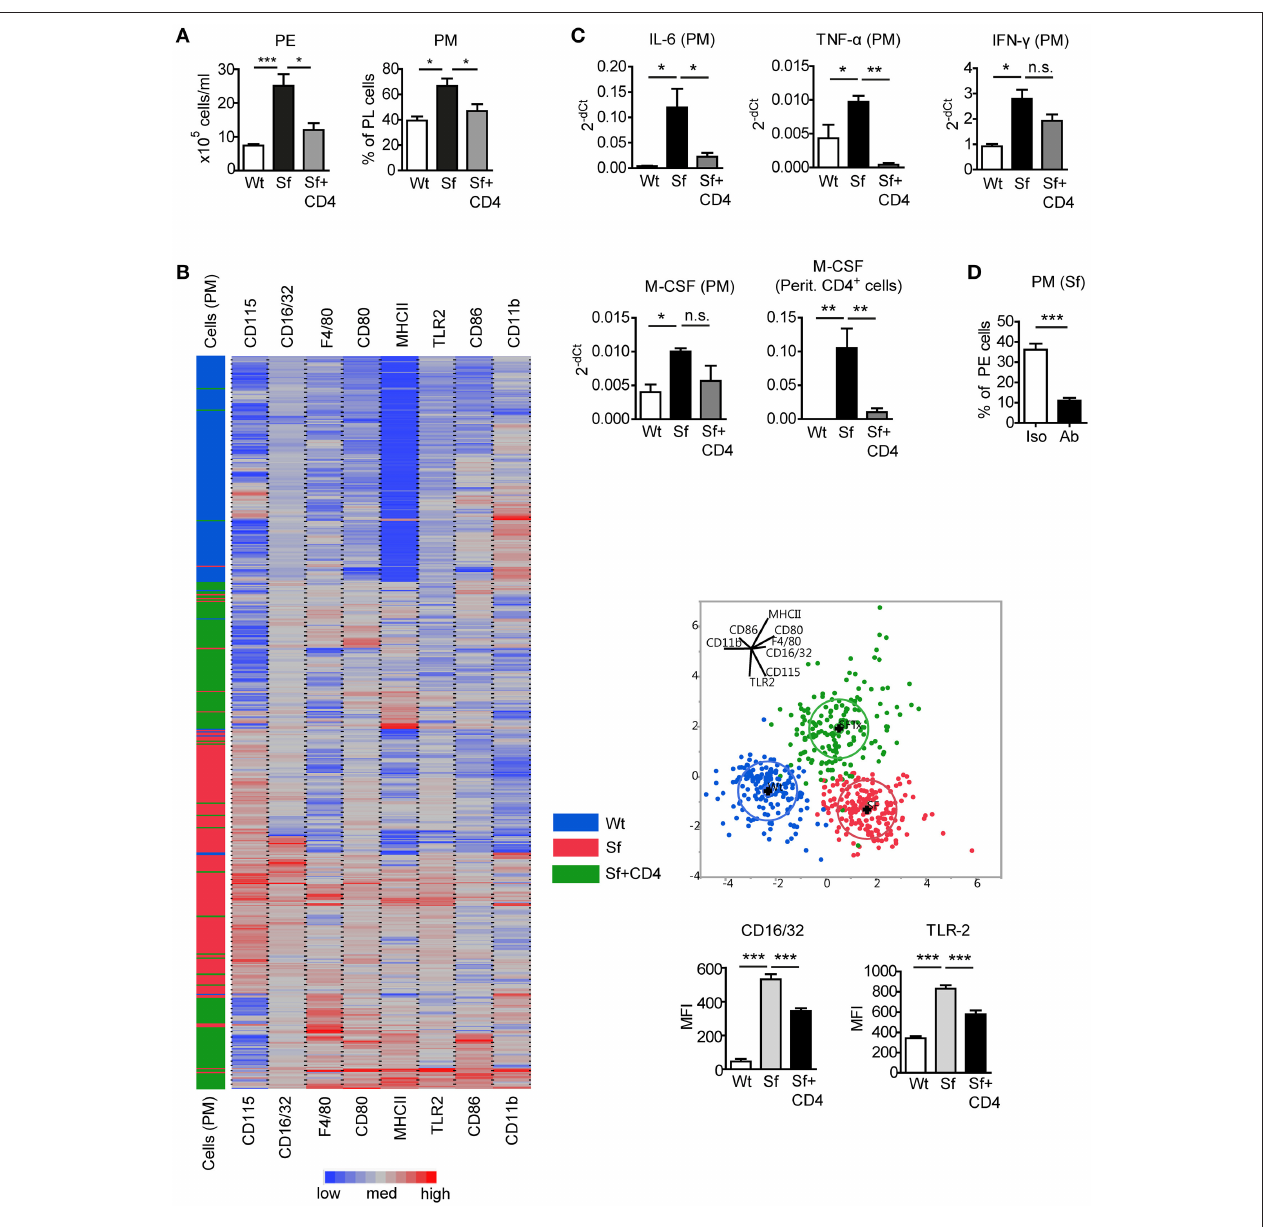
FIGURE 4 | Injection of Wt CD4 + T cells to Sf mice restores PM number and inflammatory cytokine expression. (A) Total peritoneal exudate (PE) cells and percentages of peritoneal macrophages (PM) in controls (Wt), scurfy mice (Sf), and adoptively transferred Sf mice with Wt CD4 + cells (Sf + CD4), analyzed by automated cell counter and flow cytometry, respectively ( n ≥ 5). (B) Heatmap, linear discriminant analysis, and bar graphs of cell surface markers measured by chipcytometry on gated CD115 + CD11b + F4/80 + PM ( n = 200 cells per group, pooled from more than 3 mice). (C) Impact of adoptive Wt CD4 + T cell transfer on cytokine mRNA expression by PM and peritoneal CD4 + T cells, measured by qPCR ( n = 3–4). (D) Percentages of PM in PE of Sf mice after in vivo treatment with anti-M-CSF antibody (Ab) or isotype (Iso) control ( n = 5 mice, data are pooled from two independent experiments). Statistical analyses were performed using one-way ANOVA (A-C) or unpaired Student’s t -test (D), * p < 0.05, ** p < 0.01, *** p <